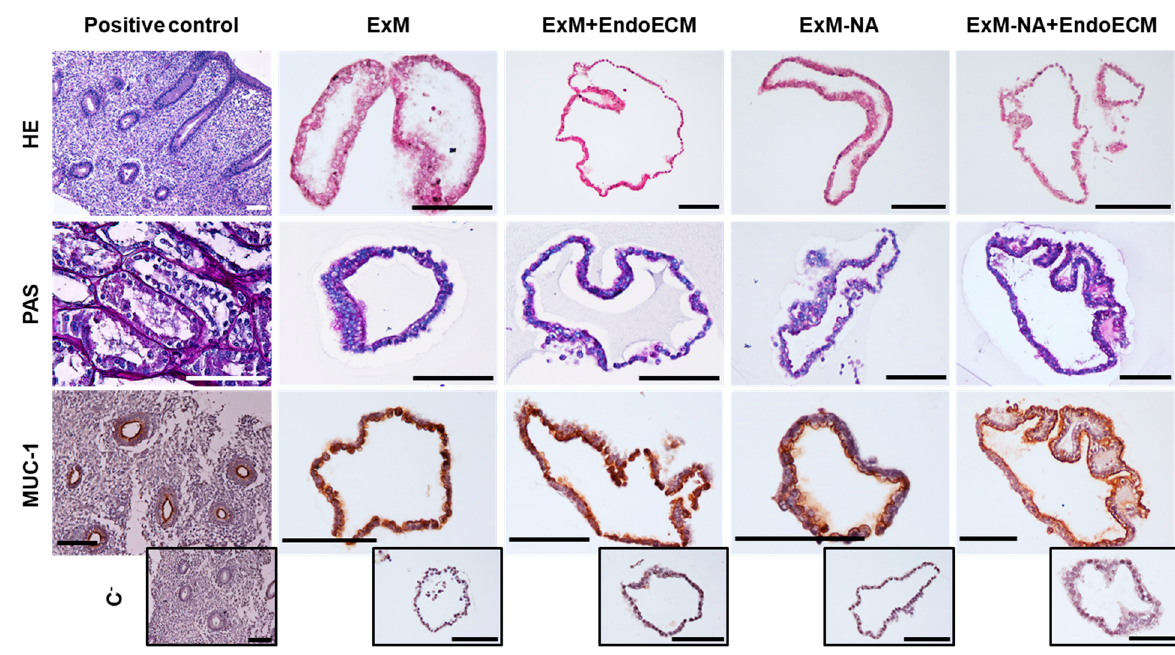
Figure 2. Characterization of glandular origin in human endometrial organoids by histological and immunohistochemical staining. H&E, PAS staining, and MUC-1 expression in positive controls (endometrium and kidney) and in human endometrial organoids cultured in the four different experimental conditions: ExM, ExM+EndoECM, ExM-NA, ExM-NA+EndoECM. Negative controls for MUC-1 are shown at the bottom of the figure in small size. Scale bars are 100 µ m.